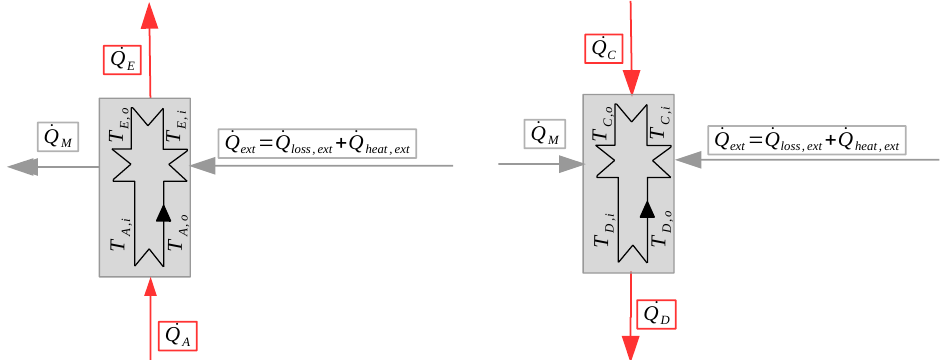
Figure A6. Energy balance of external heat-transfer circuit for discharging ( left ) and for charging ( right